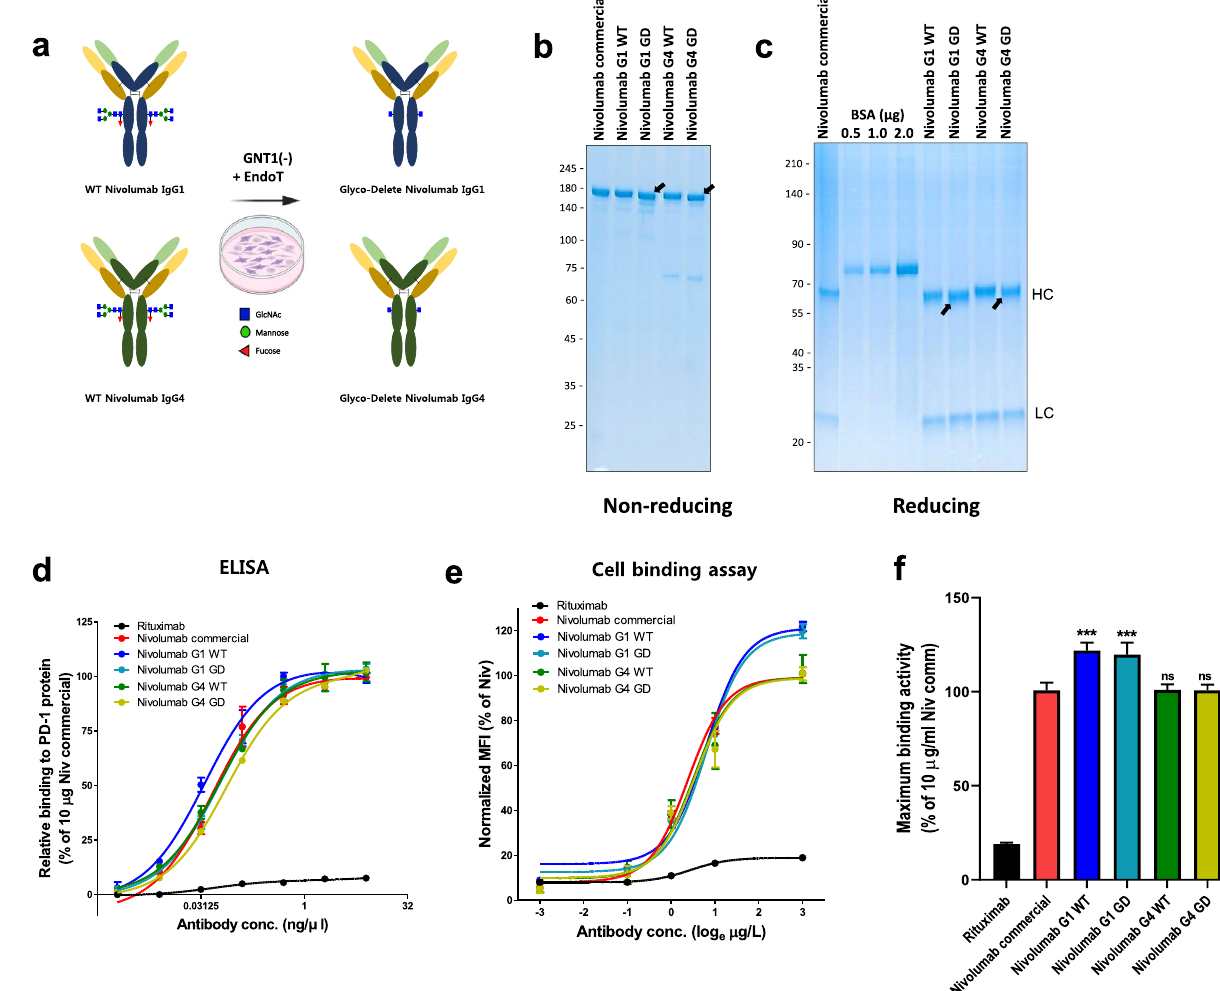
Figure 1. Production of CHO-GD nivolumab with IgG1 and IgG4 backbone ( a ) Schematic graphic of the GD process of nivolumab in the CHO cell system. ( b ) Nivolumab commercial, nivolumab IgG1 WT, nivolumab IgG1 GD, nivolumab IgG4 WT, and nivolumab IgG4 GD were subjected to SDS-PAGE under non-reducing and reducing conditions. BSA (0.5, 1.0, and 2.0 μg) was used as the standard. ( b , c ) CHO-nivolumab, CHO- nivolumab IgG1 WT, CHO-nivolumab IgG1 GD, CHO-nivolumab IgG4 WT, and CHO-nivolumab IgG4 GD were subjected to SDS-PAGE under non-reducing ( b ) and reducing ( c ) conditions. BSA (0.5 μg, 1.0 μg and 2.0 μg) was used as the standard. Binding affinity of each antibody (CHO-nivolumab, CHO-nivolumab IgG1 WT, CHO-nivolumab IgG1 GD, CHO-nivolumab IgG4 WT, CHO-nivolumab IgG4 GD, and rituximab) was analyzed via ELISA using recombinant human PD-1 protein (d) and via FACS using PD-1 expressed CHO cells (e) . Rituximab was used as a negative control for both analyses. (d) ELISA was performed with plates coated with recombinant human PD-1 protein, and the bound antibodies were detected with HRP-conjugated anti-human IgG antibody. (e,f) The binding capacities of the antibodies against PD-1-expressing CHO cell are sown in dose-dependent manner dependent (0.1 μg/mL, 0.3 μg/mL, 1 μg/mL, 3 μg/mL, and 10 μg/mL) (e) and the binding activity of each antibody at the maximum concentration (10 μg/ml) is summarized. (f) using flow cytometry and 2nd-anti human IgG-FITC. The mean fluorescence intensity (MFI) of FITC treated with nivolumab commercial (10 μg/mL) was normalized to 100%. The MFI of each antibody-treated cell was expressed as the relative %. ***p ≤ 0.001 compared to 10 μg/mL of nivolumab commercial. Rituximab was used as negative control in (d) and ( e,f) erase reporter cells or cytokine release from Jurkat PD-1 cells was induced by an anti-CD3/CD28 activator, and the recovery of activity followed by treatment with 30 μg/mL of each antibody was measured based on the attenuated PD-L1 engagement. To validate the specificity of PD-L1-dependent PD-1 activation, WT HEK 293 T cell or human PD-L1-overexpressing HEK 293 T cells (Fig. 2b) and breast cancer cell lines MCF7 (PD-L1 (−)) or MDAMB231 (PD-L1 (+)) (Fig. 2c,e,f) were used. hPD-L1-overexpressing HEK293T cells (Fig. 2b) and MDAMB231 (Fig. 2b,e,f) showed lower luciferase activity and low cytokines secretion compared to those in WT HEK293T and MCF7 cells, respectively. Furthermore, significantly higher luciferase activity and cytokine